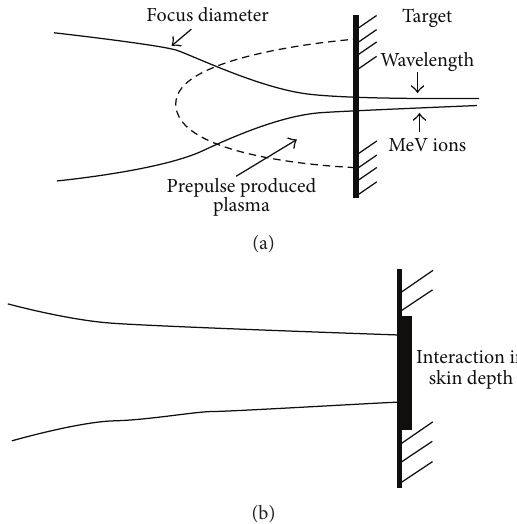
Figure 2: Laser interaction with a target, (a) if the laser pulse produced a plasma plume in front of the target by a prepulse causing shrinking of the beam to less than one wave length diameter due to relativistic self-focusing and (b) avoiding the prepulse for plane geometry interaction within the skin